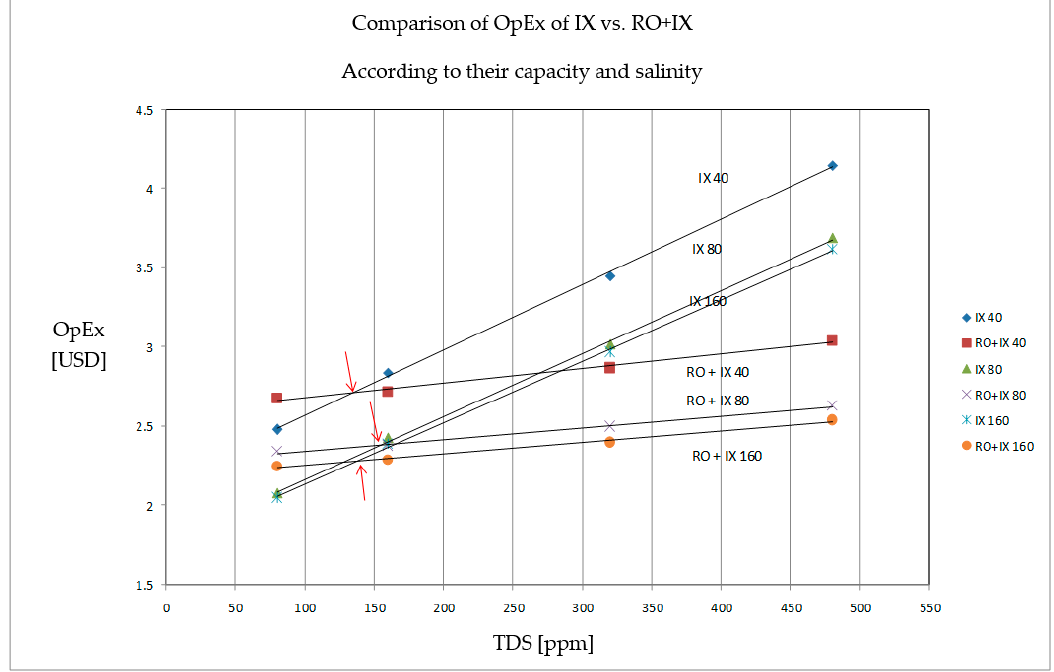
Figure 2. Comparison of OpEx of IX (ion exchange) technology and IX + RO (reverse osmosis) by Beardsley, DOW company (1994), according to TDS and capacity (40, 80 and 160 m 3 .h − 1 ) [4].